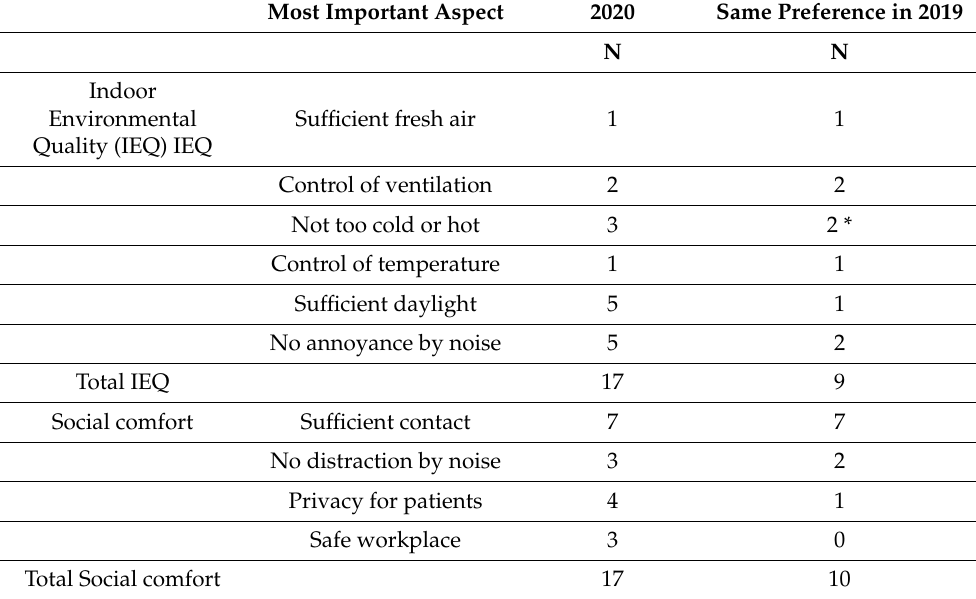
Table 2. Main preference in 2020 compared to